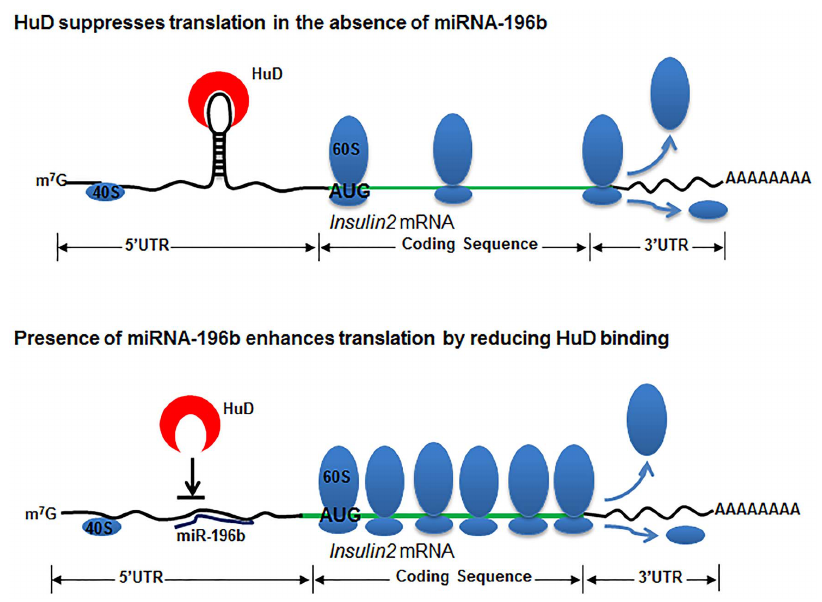
Figure 6. Mechanism of miR-196b action. The miR-196b target site is at the 5 9 UTR stem loop structure of the insulin2 mRNA. Targeting of miR- 196b to the stem-loop region of the insulin2 mRNA disrupts the secondary structure and prevents binding of the translational inhibitor, resulting in the activation of insulin translation.